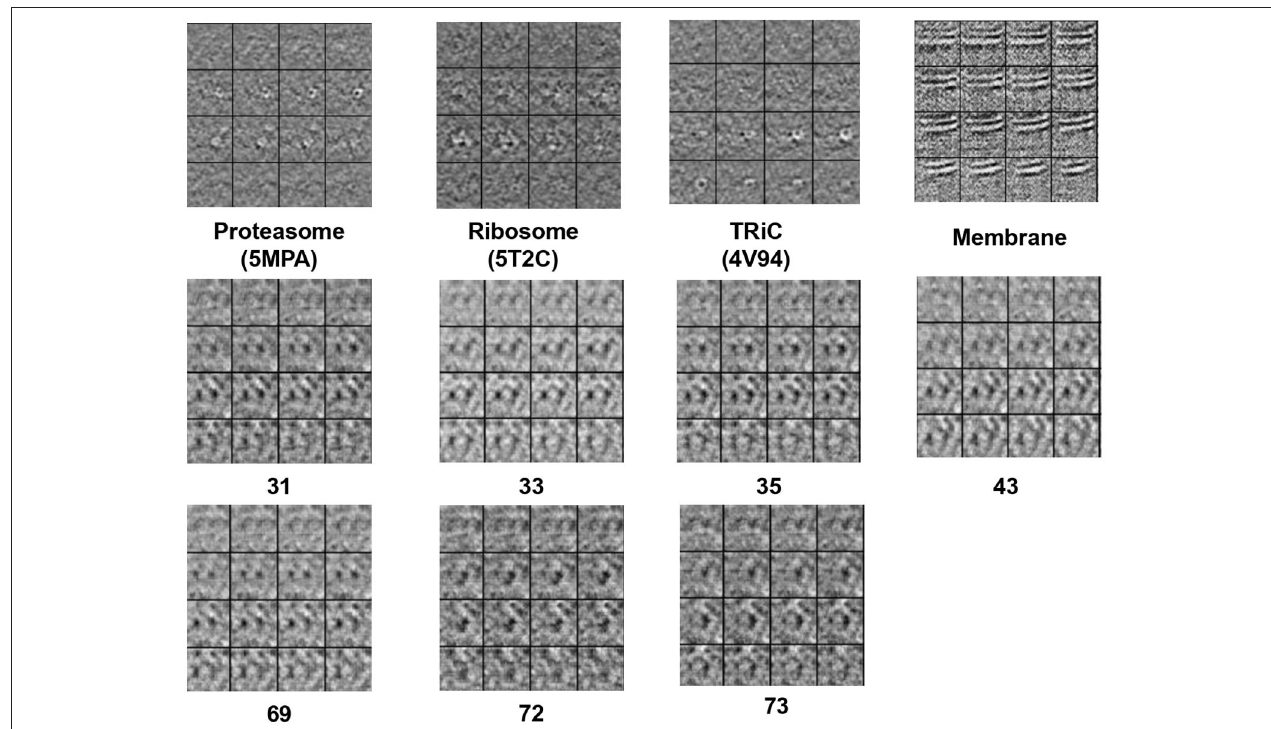
FIGURE 3 | The 2D slide visualization of real subtomogram samples from every class ( Top : S e 1 , Middle and Bottom : S e 2 ), the sequence of those subtomograms is corresponding to the sequence in Table 1 .